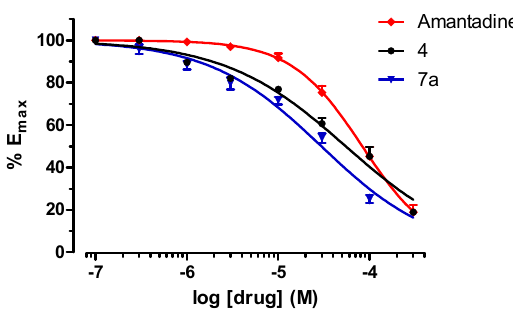
Figure 4. Inhibitory effect on NMDA-induced intracellular calcium increase in cultured cerebellar granule neurons treated with increasing doses of amantadine, 4 and 7a . Table 1. IC 50 values obtained for compounds 4 , 7a , and